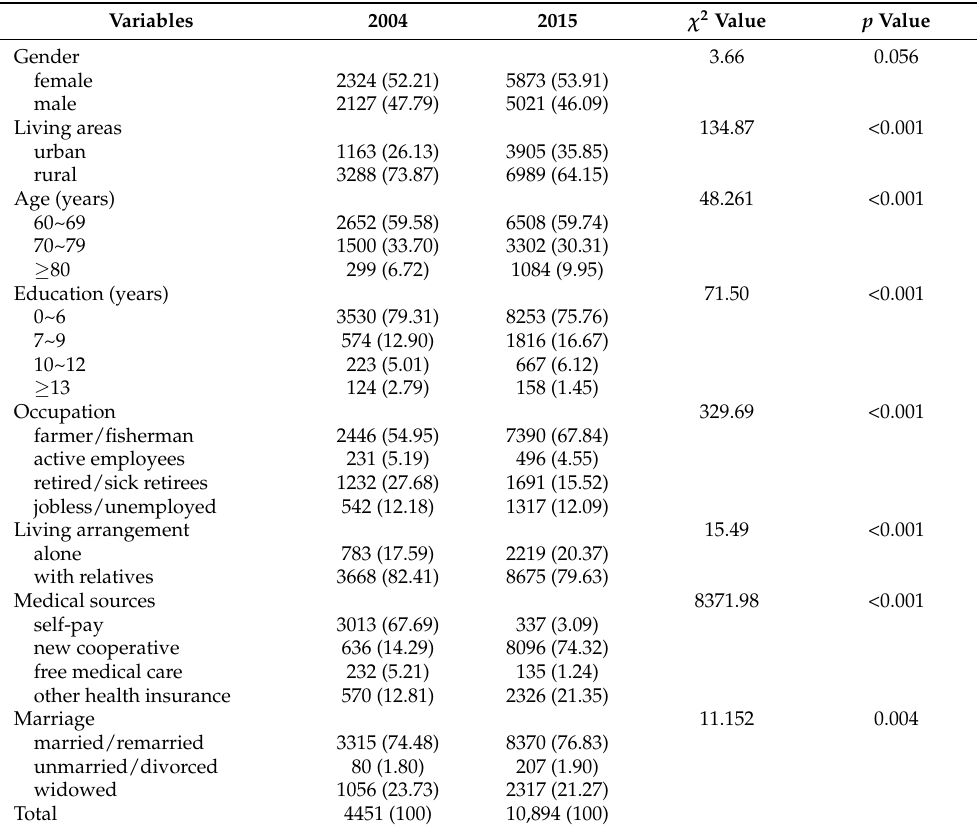
Table 1. Socio-demographic characteristics of the study population in 2004 and 2015, n (%).